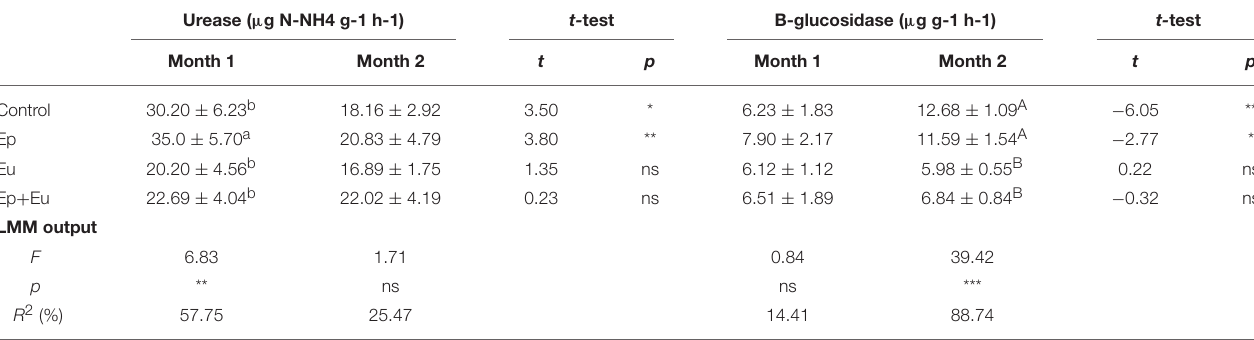
TABLE 4 | Urease and beta-glucosidase activities (means ± standard deviation) of four experimental treatments in 1 and 2 months after Collembola re-inoculation.